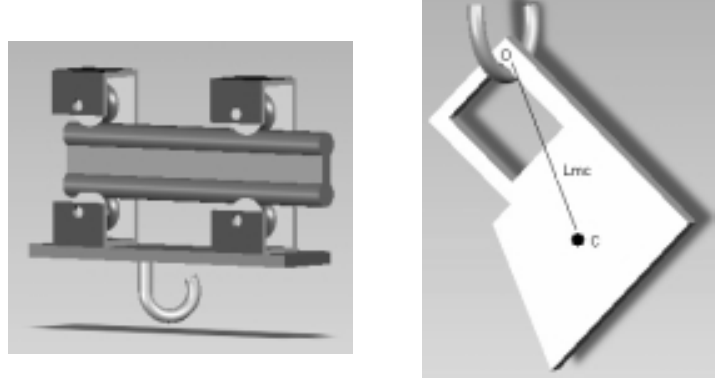
Fig. 1. (a) Sketch of an overhead transportation system. (b) Rigid solid hanging from the